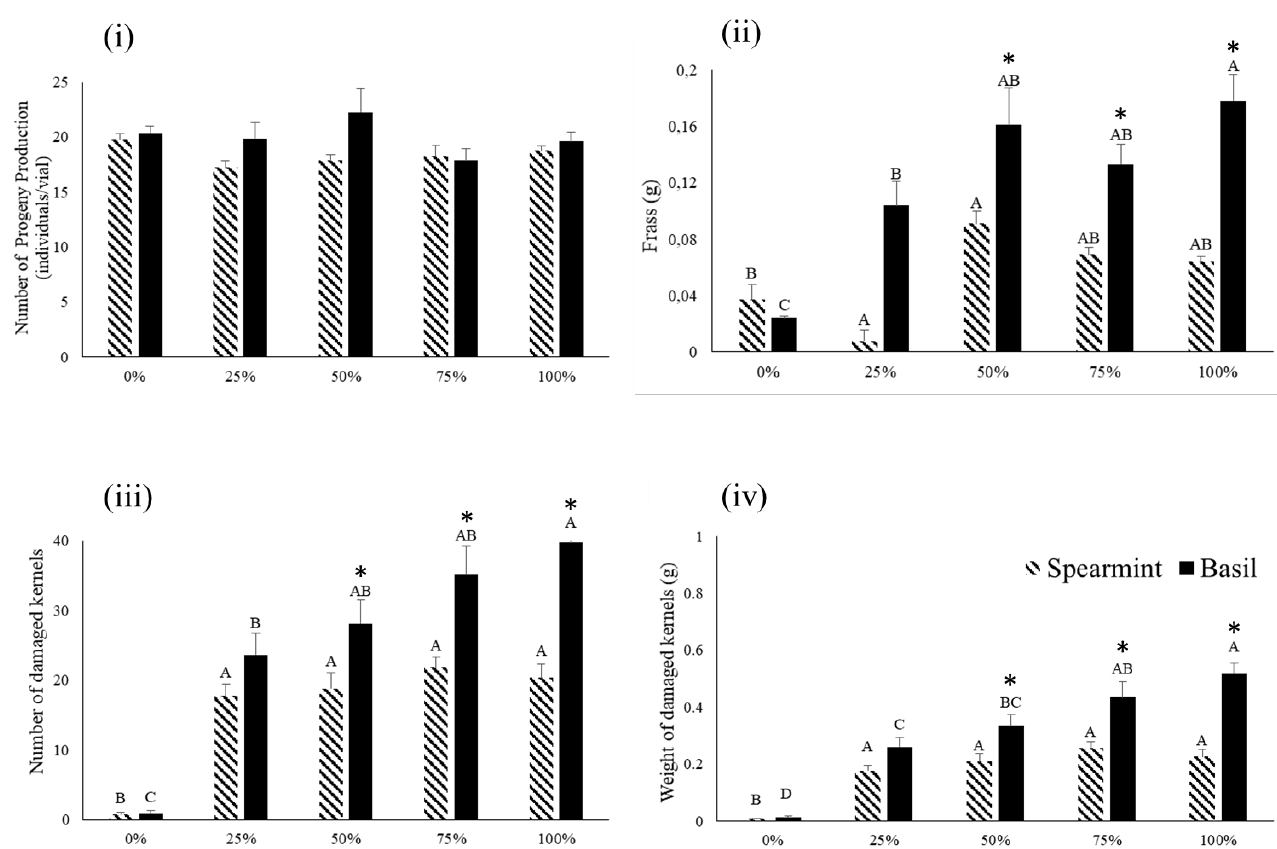
Figure 2. Mean ± of progeny production ( i ), frass ( ii ), number of damaged kernels ( iii ) and weight of damaged kernels ( iv ) of Rhyzopertha dominica . Within each fortification (rice fortified with spearmint or basil) means followed by the same uppercase letter are not significantly different (Tukey-Kramer HSD test at 0.05). Where no letters exist, no significant differences were noted. Within each treatment, means with asterisks (*) indicated significant differences between the two fortified commodities (spearmint and basil) tested according to Student’s t -test at 0.05. t -test parameters for frass at 50% were: t = 6.334, p = 0.024; at 75% were t = 17.479, p < 0.001; and at 100% were t = 33.175, p < 0.001. For NDK, t -test parameters at 50% were t = 5.142, p = 0.039; at 75% were t = 9.055, p = 0.009; and at 100% were t = 29.141, p < 0.001. For WDK t -test parameters at 50% were t = 5.747, p = 0.0310; at 75% were t = 8.644, p = 0.0108; and at 100% were t = 37.619, p < 0.001. In all cases, df total =